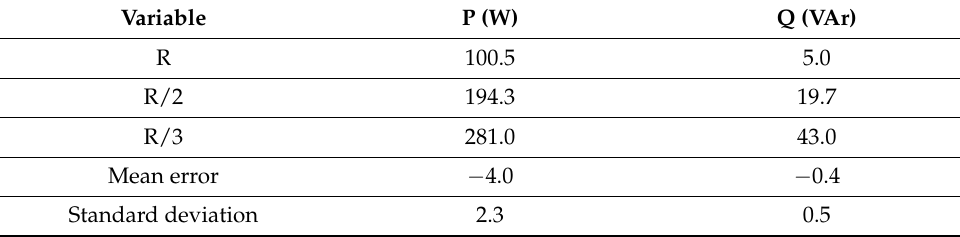
Table 8. Powers from Yokogawa ® for RL